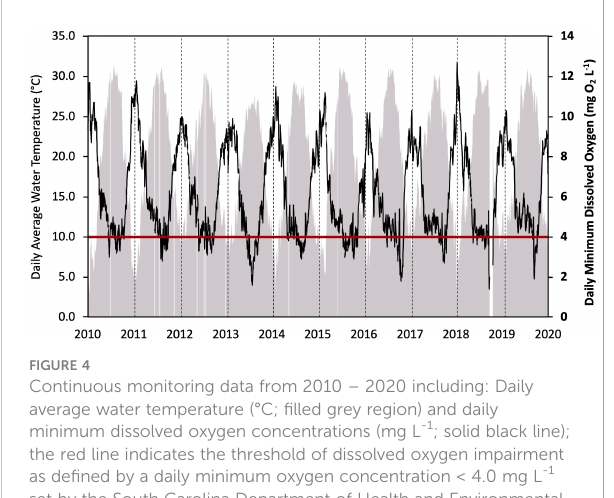
FIGURE 5 Dissolved oxygen (mg L -1 ), plotted as observed monthly average (black circles) and expected saturation concentration (solid red line), and average monthly temperature (°C) from 2010-2020 from data collected at USGS site 2110704 (Waccamaw River at Conway Marina, at Conway, SC). Expected saturation concentrations were calculated via site temperature, altitude, and an assumed salinity of 0. The dashed grey line represents a linear regression model, which displays a signi fi cant negative relationship between dissolved oxygen and temperature (p < 0.001, R 2 = 0.89).